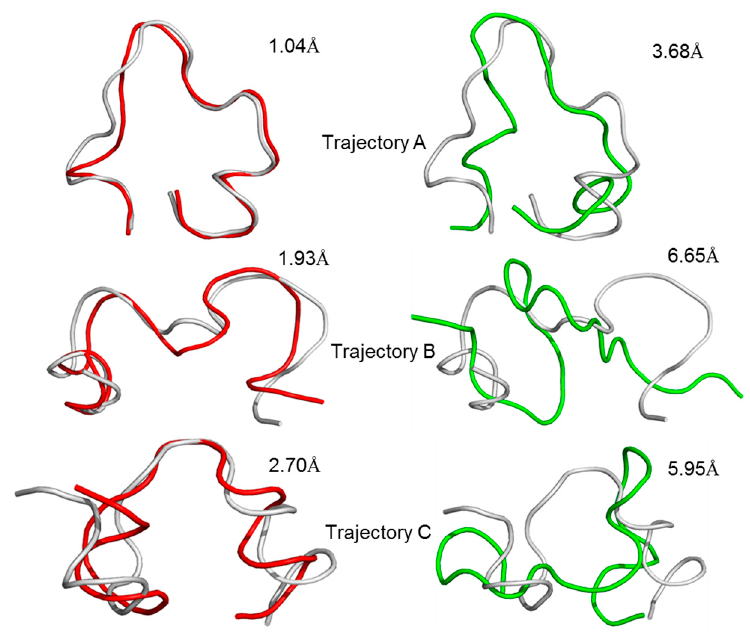
Figure 4. Representative structures and the calculated RMSD values of the representative structures between the first 10 ns (gray) and 50 ns (red), the first 10 ns and the last 100 ns (green) for the repeated trajectories A , B and C .